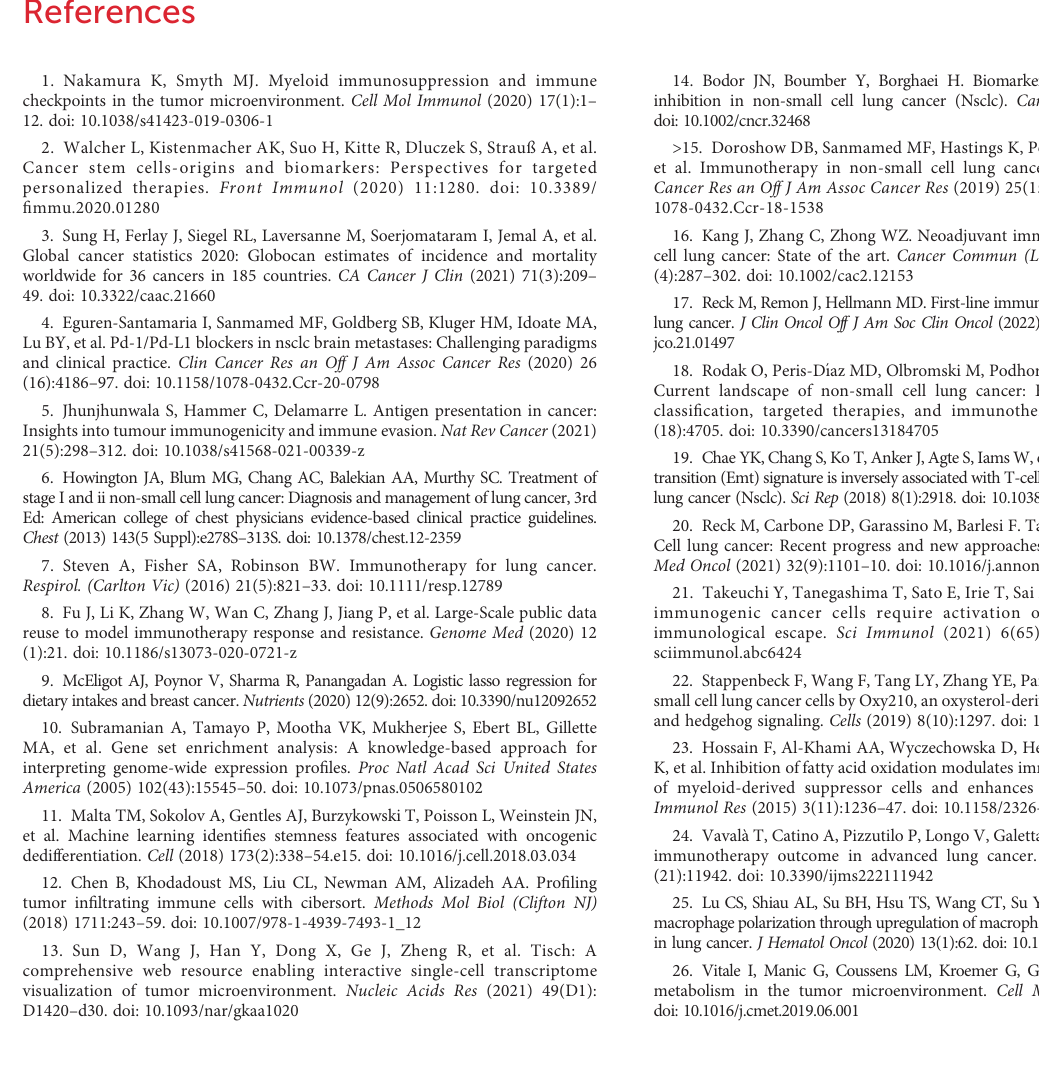
SUPPLEMENTARY FIGURE 1 The fl ow chart of whole study. SUPPLEMENTARY FIGURE 2 Molecular typing based on characteristic genes in the TCGA database. SUPPLEMENTARY FIGURE 3 GO and KEGG